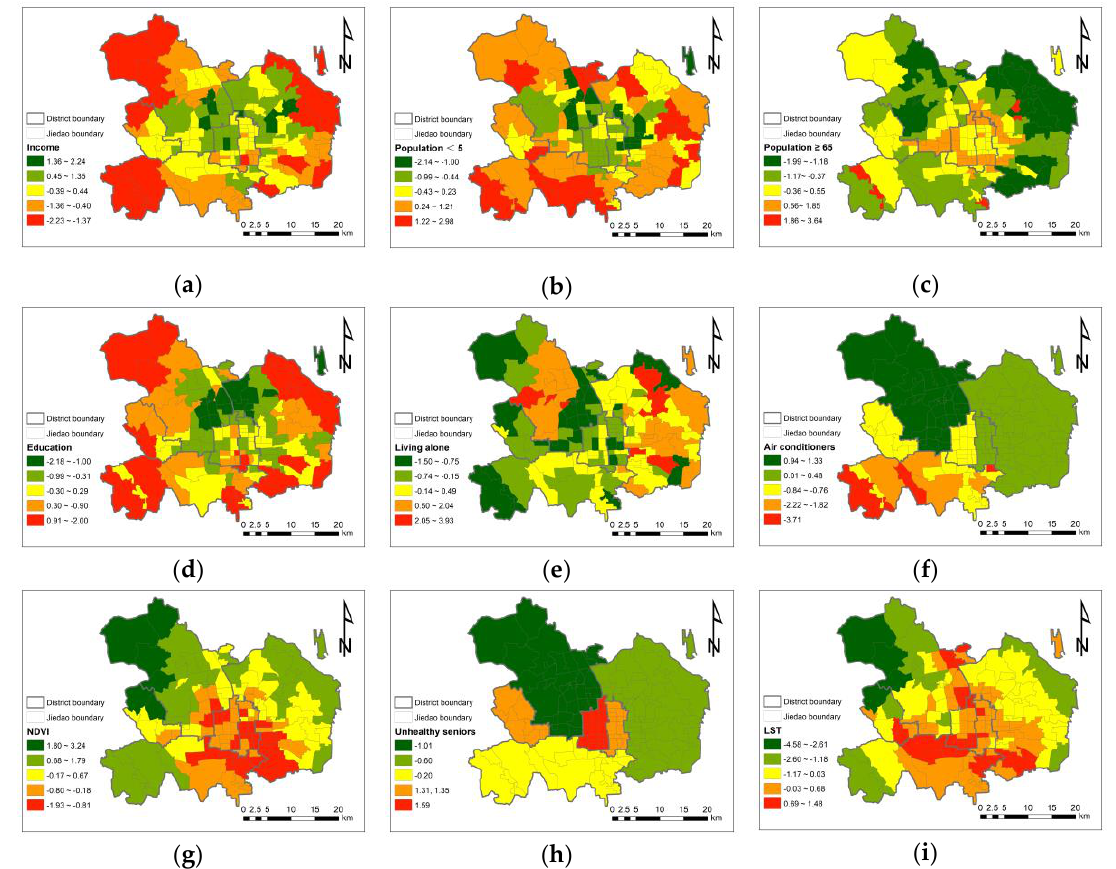
Figure 5. Spatial pattern of heat vulnerability variables in Beijing: ( a ) income; ( b ) percentage of the population under the age of five; ( c ) percentage of the population aged 65 and over; ( d ) education status; ( e ) percentage of persons living alone; ( f ) number of air conditioners per 100 households; ( g ) NDVI; ( h ) unhealthy elderly people over 60 years of age; ( i ) LST. Among them, education factor is composed of the percentage of the population that is illiterate (positive indicator), the percentage of the population with high school education (positive indicator), and the percentage of the population with college education and above (negative indicator).